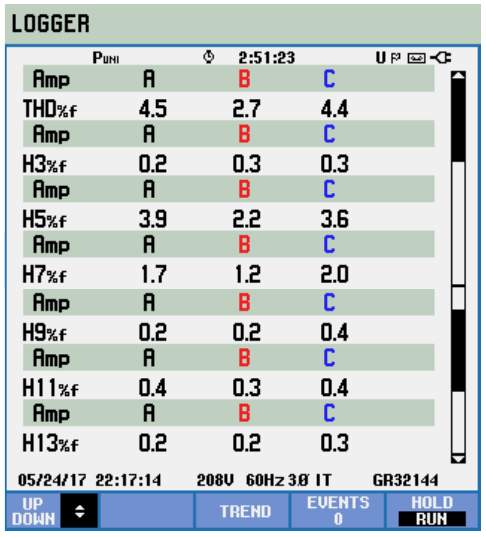
Figure 12. Three-phase grid current harmonic components with the DHPF-NSI